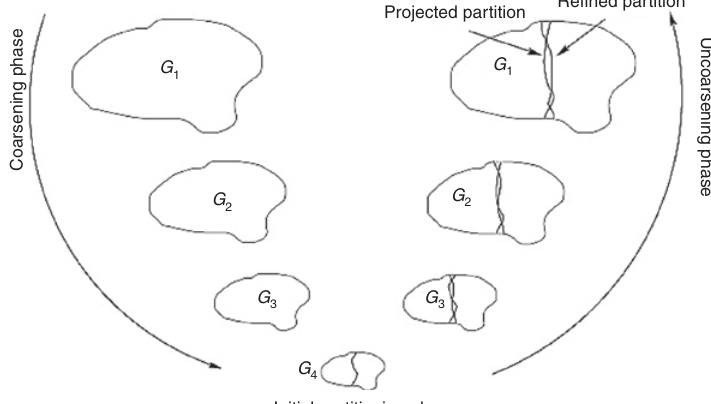
Figure 1: The Multi-Level Method of Weighted Hypergraph